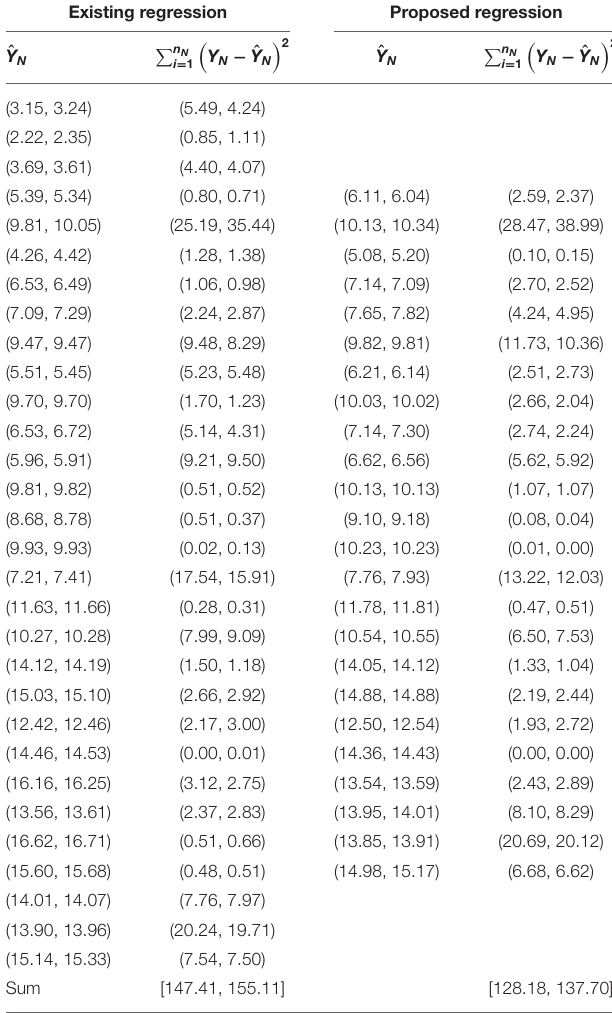
TABLE 3 | The trended values and error sum of square for two regression models. Existing regression Proposed